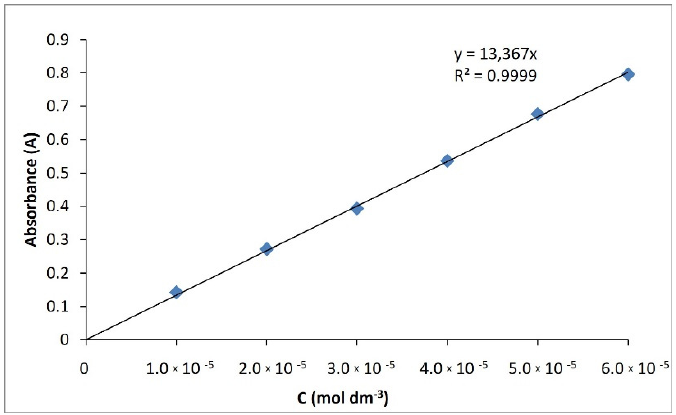
Figure 14. Calibration curve of compound I .